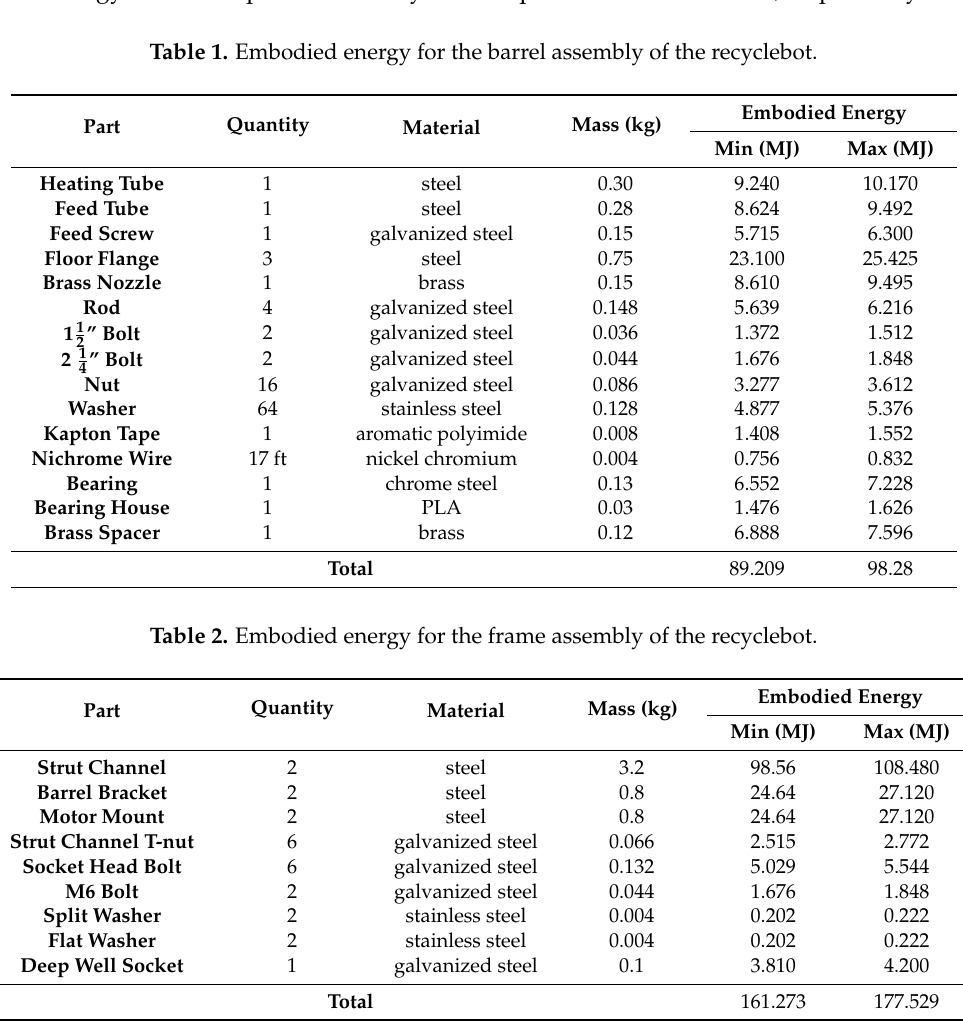
Table 3. Embodied energy for the motor assembly of the